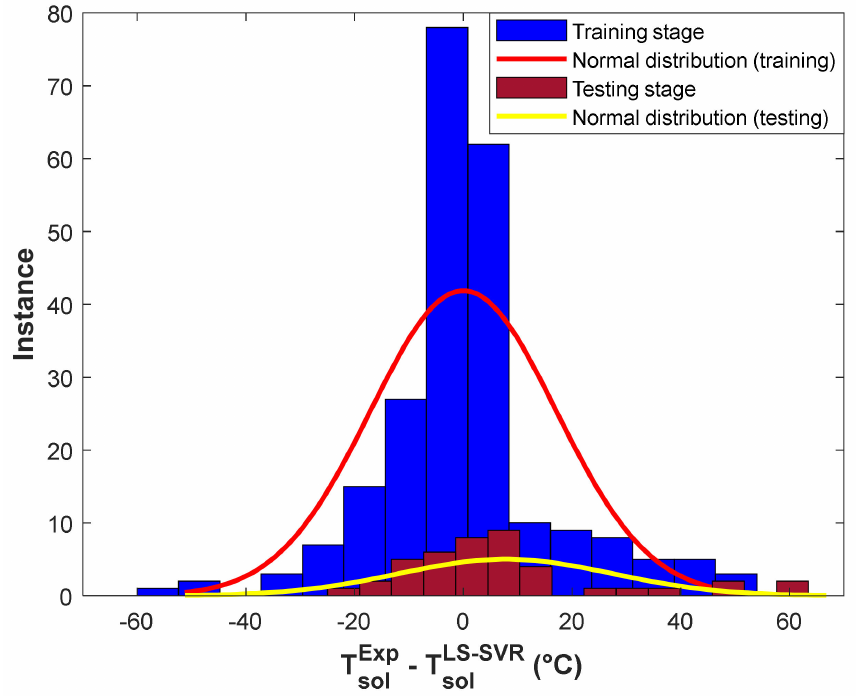
Figure 4. Histogram of residual errors of the structure-tuned LS-SVR in the training and testing